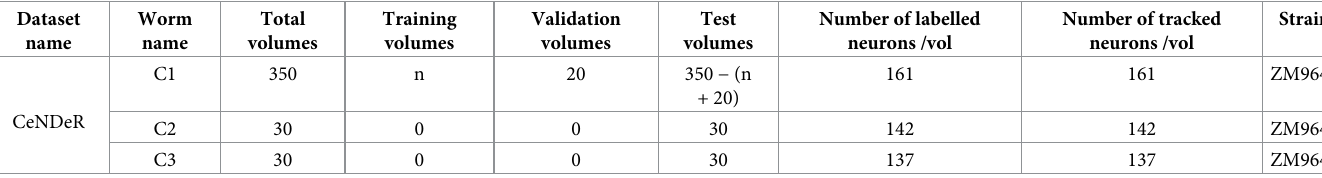
Table 1. The organization of CeNDeR dataset. To train and test CeNDeR, we used 3 human-annotated worms specified as C1, C2 and C3 in this paper. “/ vol” indicates an average number per volume. Dataset